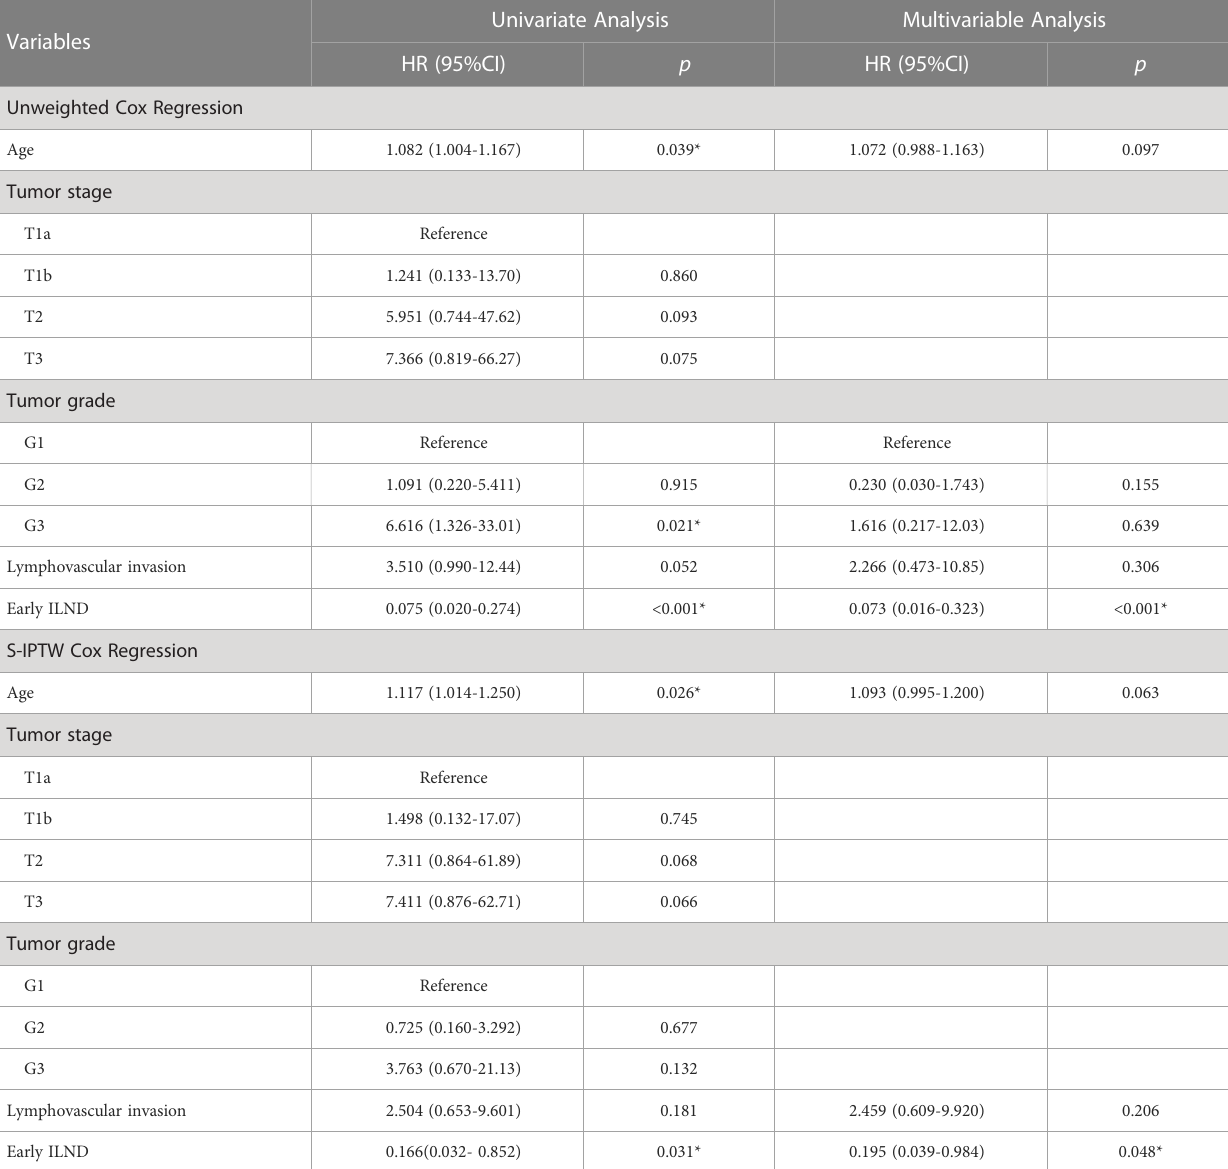
TABLE 5 Univariate and multivariable Cox regression in 52 cN0 penile cancer patients who underwent either early ILND or late ILND, with unweighted and S-IPTW adjustments.